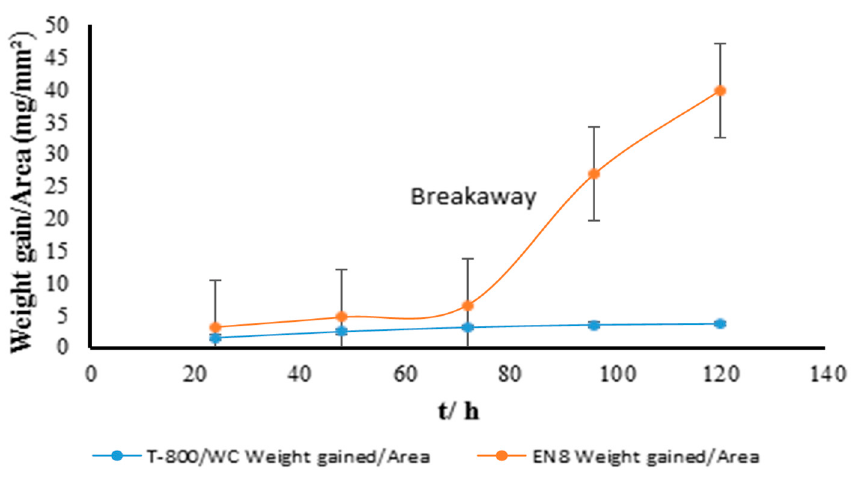
Figure 1. Kinetic information of the oxidation of the T-800/WC cladding coating and the substrate at 800 °C.